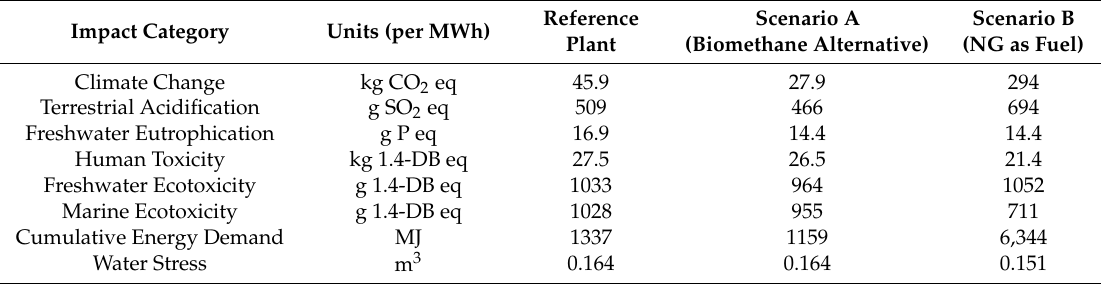
Figure 7. Normalization profile of the reference plant compared to Scenario A (Biomethane alternative) and Scenario B (NG as auxiliary fuel) per impact category. Table 4. Comparison of characterized results between the reference HYSOL plant and the alternative scenarios (A = biomethane as auxiliary fuel using digestate as fertilizer, B = natural gas (NG) as auxiliary